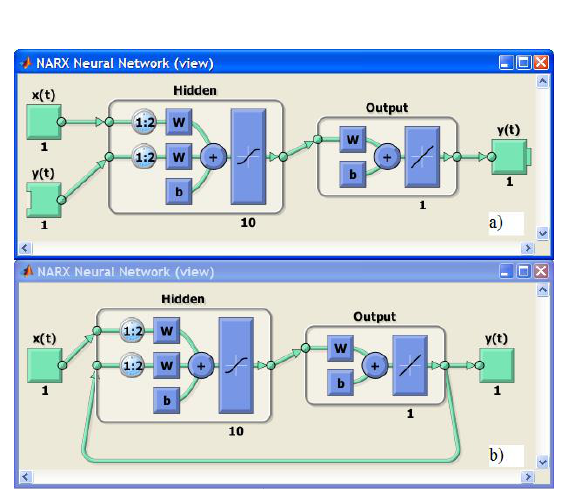
Figure 9. View of Matlab model both in (a) opened and (b) closed states.